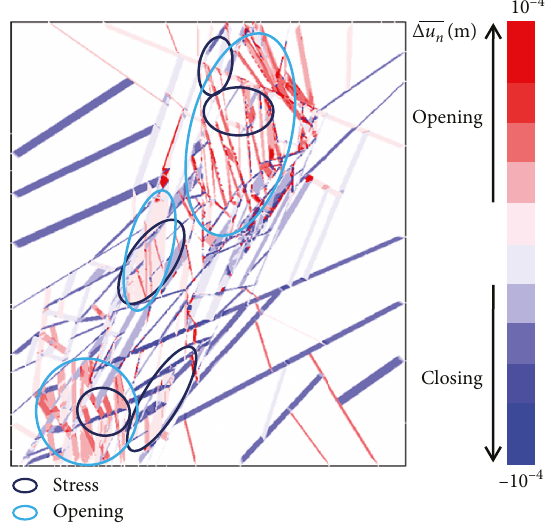
Figure 11: Normal displacement variations of fault zones and corresponding favourable areas (in purple). Blue circles are a reminder from the mean stress